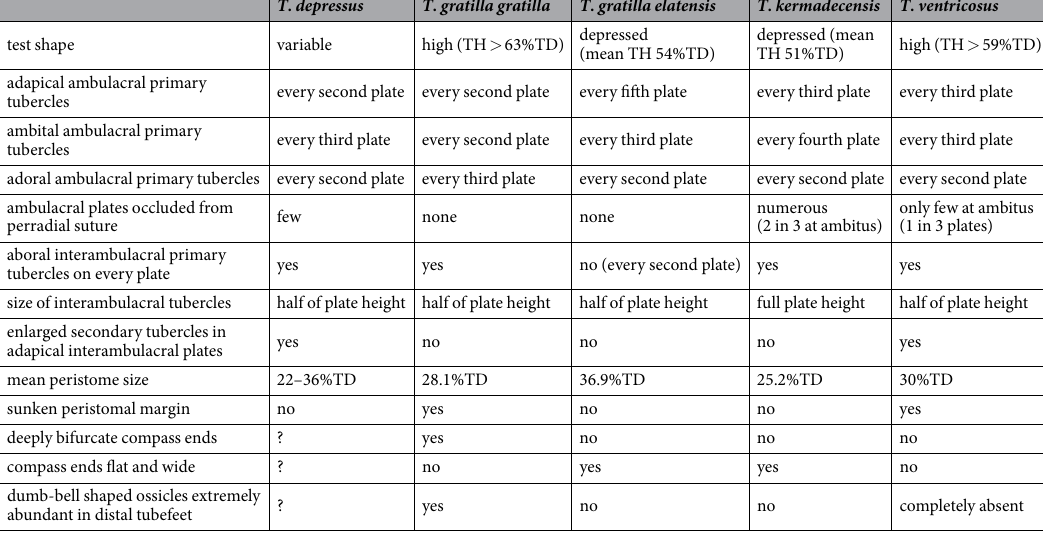
Table 1. Key morphological feature of Tripneustes